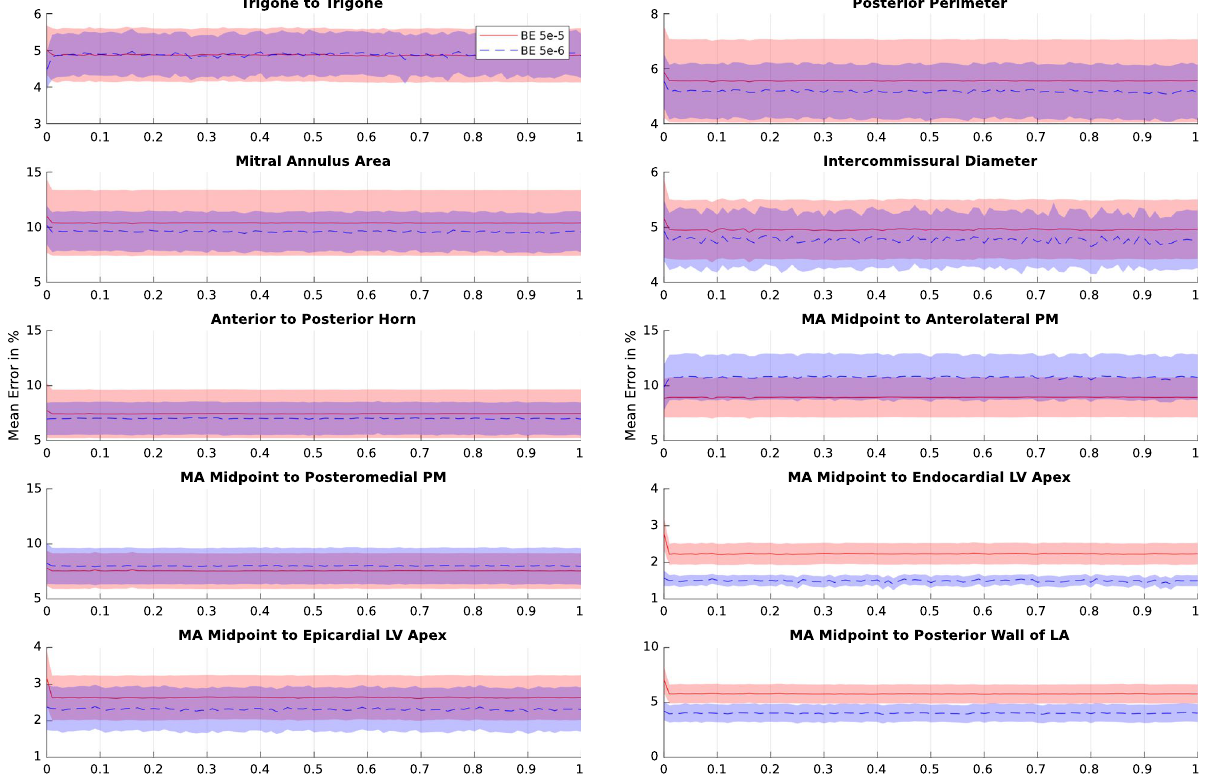
Figure 3. X axis is the examined range for the sparsity weight optimisation, whereas Y axis displays the average error in percentage on the training sets. The two curves in the plot correspond to the two values for the bending energy. Standard error is illustrated as a shaded region. Sparsity weight does not show a significant effect on the